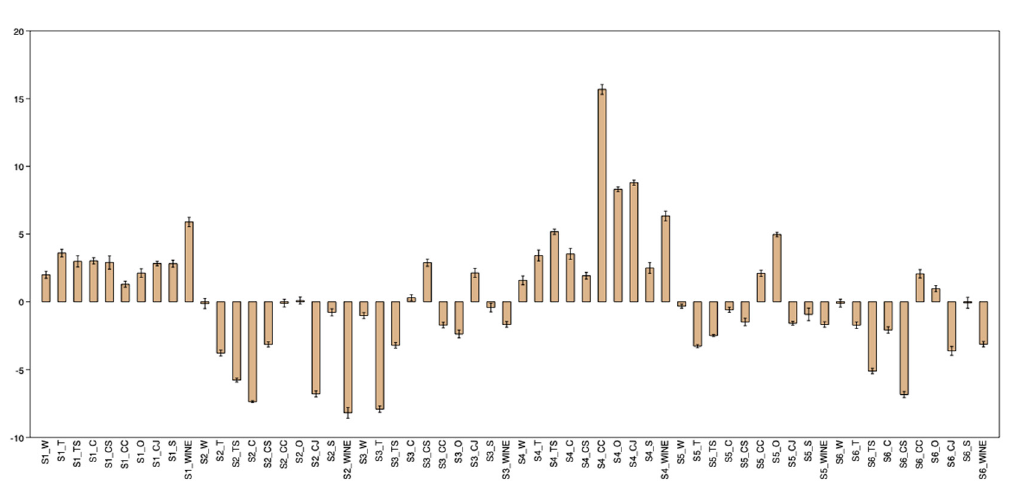
Figure 1. Δ E values at the end of the experiment for all staining liquids. Suffixes denote the liquid